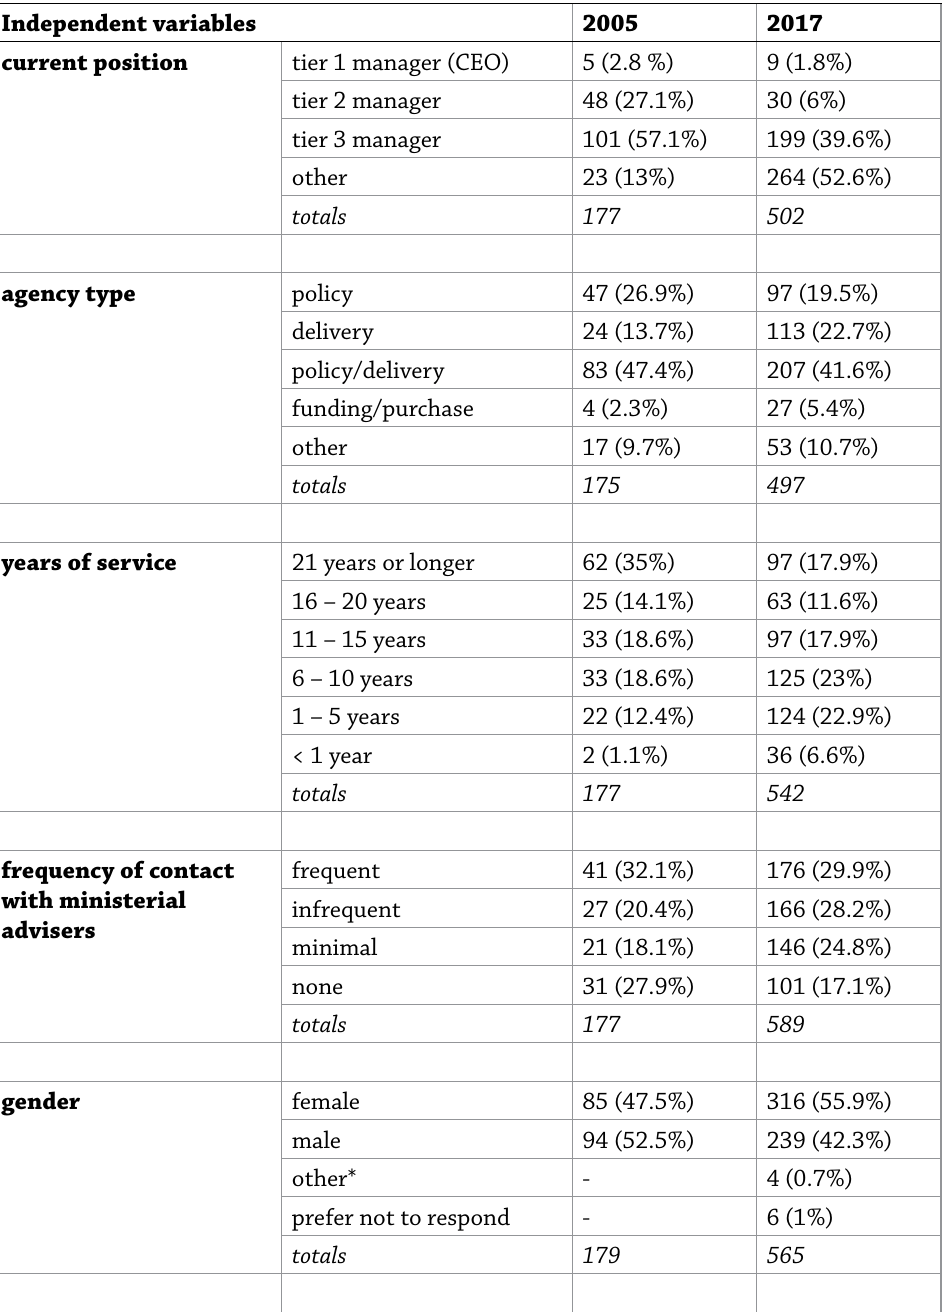
Table 1: Comparing respondent groups: 2005/2017 (n; % all respondents) Independent